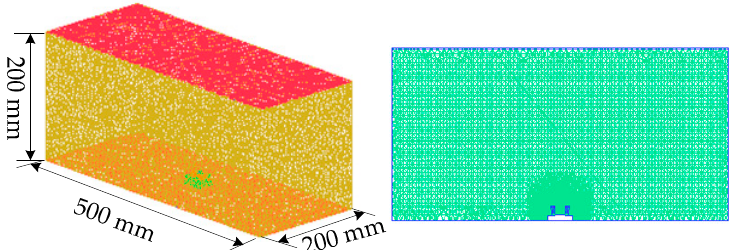
Figure 3. Computational domain and grid.